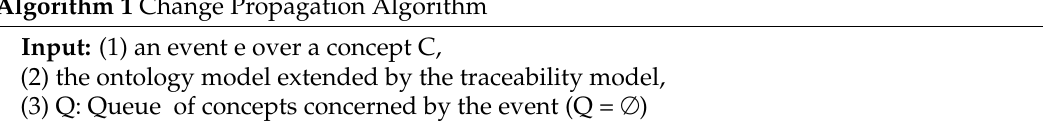
Algorithm 1 Change Propagation